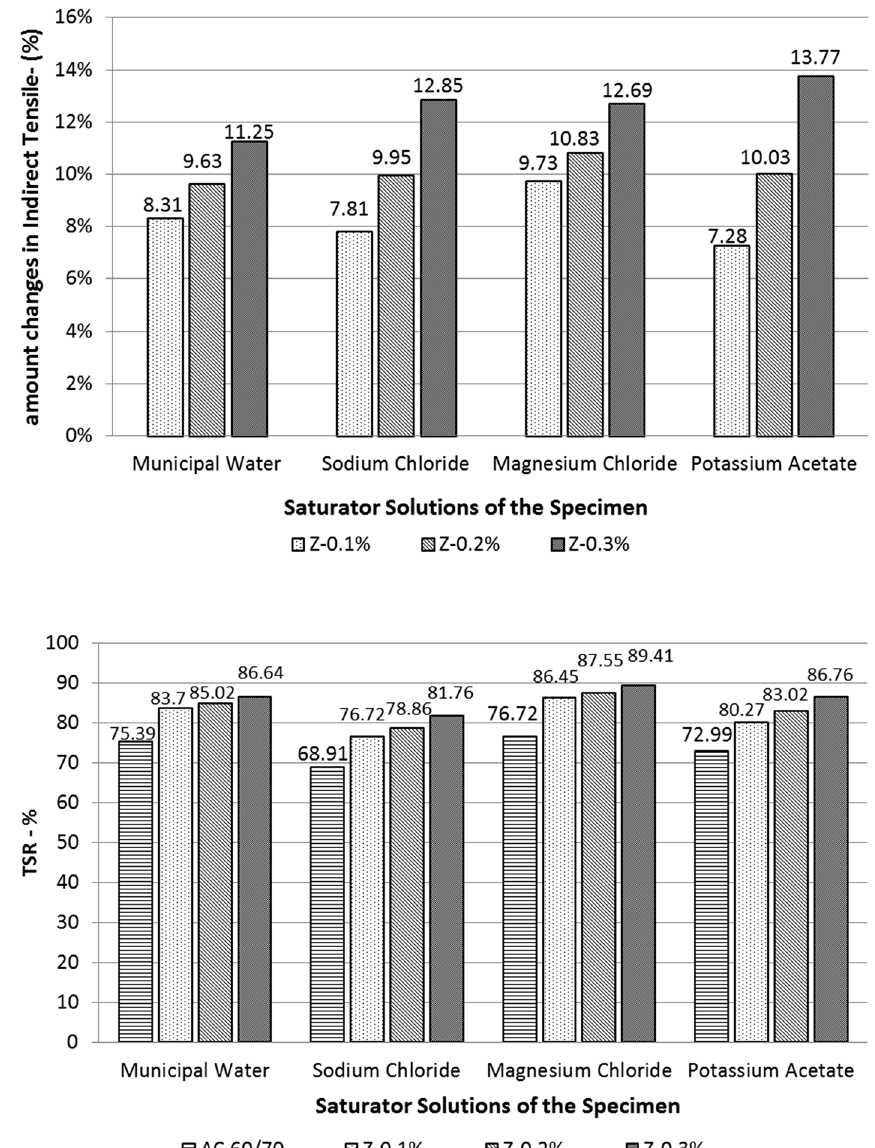
Fig. 8 Indirect Tensile Strength ratio of mixes with nano- zychotherm Pure Bitumen to mixes with pure bitumen under moist conditions (satu- rated with different deicing